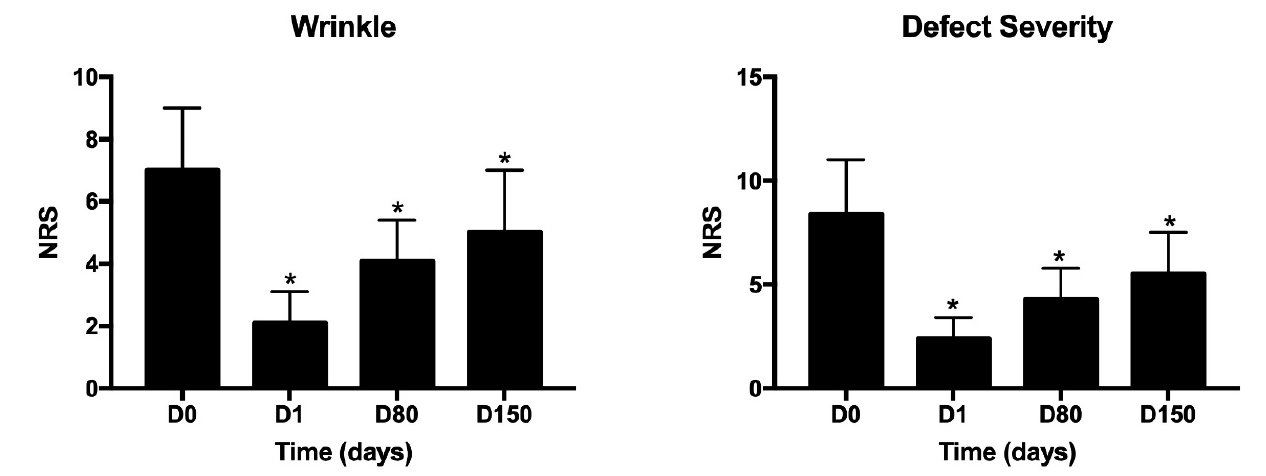
Figure 3. Numeric Rating Scale (NRS) evaluating defect severity and wrinkles. 10–0 Numeric Rating Scale (NRS) with separate scores for each site (10 = High wrinkle signs or High defect severity; 5 = Medium wrinkle signs or medium defect severity; 0 = Low wrinkle signs or medium defect severity); * p < 0.05.